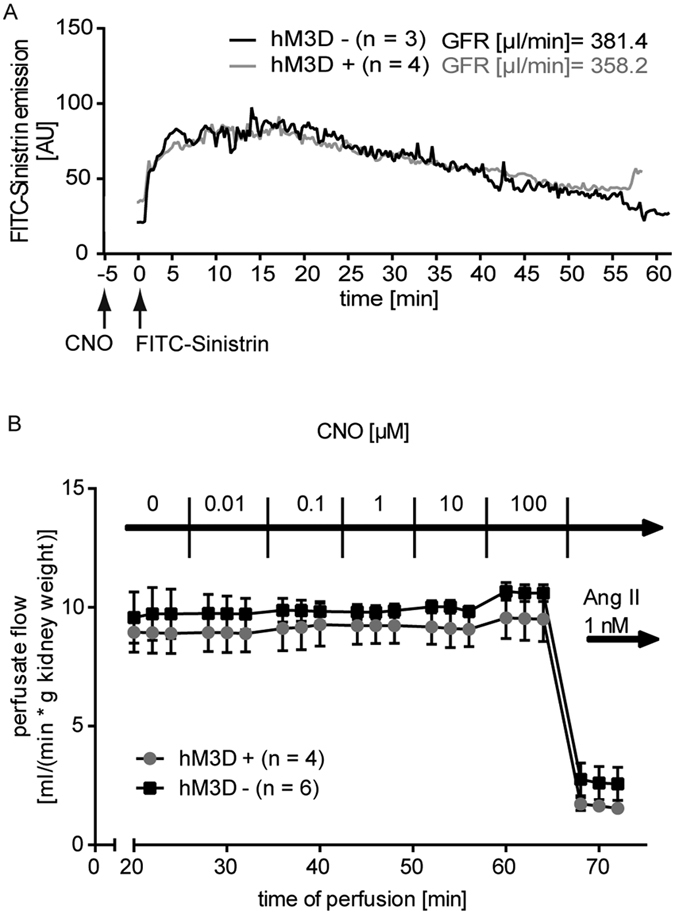
Increased intracellular Ca2+levels do not affect glomerular filtration or ex vivo kidney perfusion.(A) Transcutaneous GFR measurement with hM3D-expressing animals in comparison to their littermate controls does not reveal changes after CNO (5 mg/kg bodyweight) administration. Displayed are means (n = 4: hM3D positive, n = 3: hM3D negative). (B) Ex vivo kidney perfusion was performed with increasing CNO concentrations. Comparing hM3D-expressing mice with their control littermates does not show differences in the vascular resistance. Angiotensin II was used as positive control. Displayed are means with standard error of the mean (SEM).